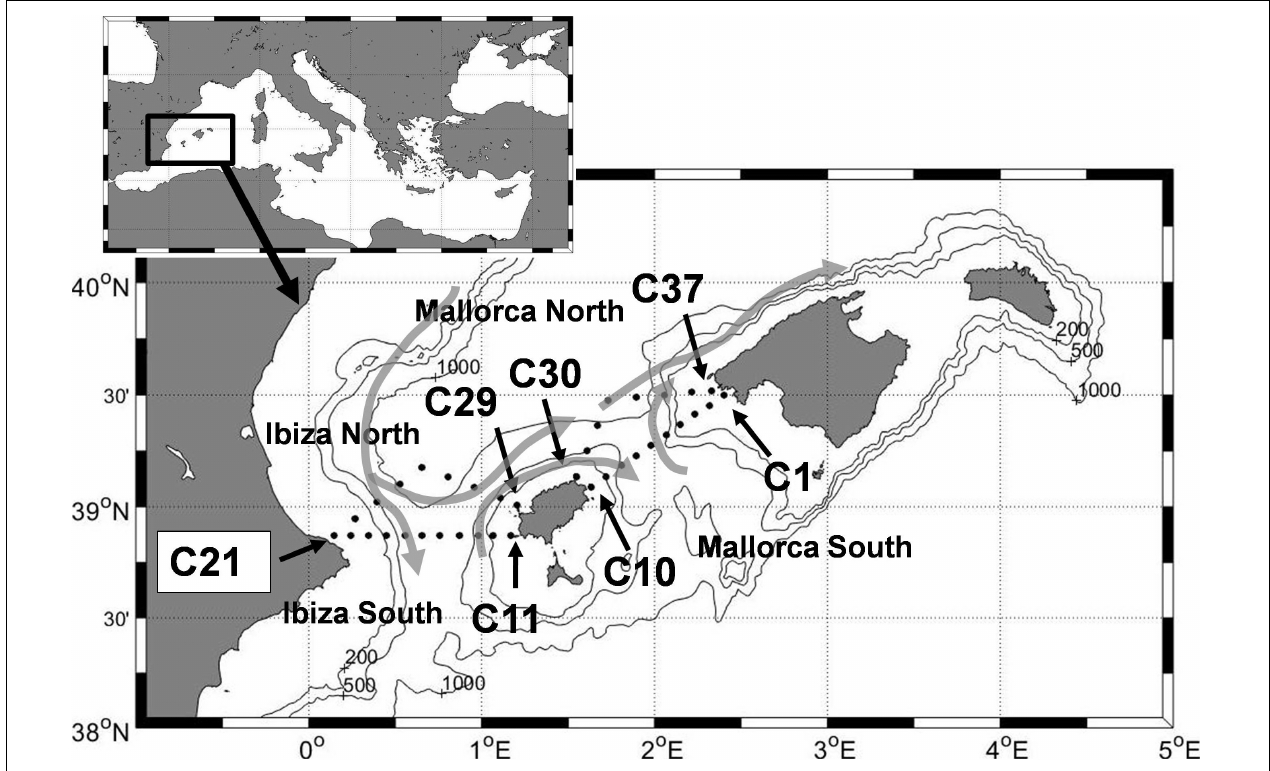
FIGURE 1 | Position of the stations monitored from 1996 to 2019 in the frame of the CANALES, CIRBAL and RADMED projects. These stations are distributed along four sections: Mallorca South (stations C1–C10), Ibiza South (C11–C21), Ibiza North (C21–C29) and Mallorca North (C30–C37). The Mallorca South and North sections form the Mallorca Channel triangle and the Ibiza South and North form the Ibiza Channel triangle. A scheme of the upper layer circulation in the Balearic Sea, inferred from the literature and this study is also